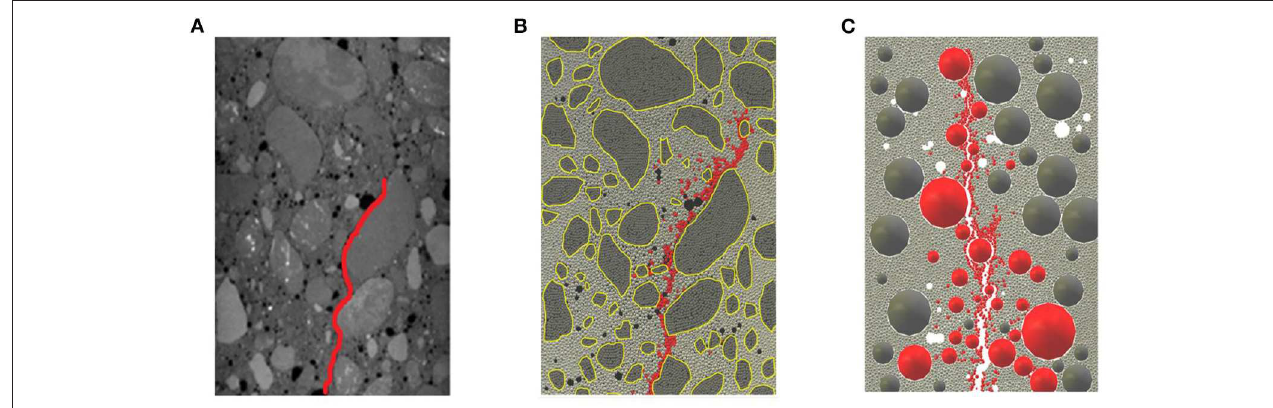
FIGURE 1 | (Color online) Mapping of the experimental sample properties to the DEM simulation (Skar˙zy´nski et al., 2015). Two-dimensional micro/meso-structure of concrete: (A) experiment (X-ray µ CT image), (B) DEM for real aggregate (clusters of spheres) and (C) DEM for real aggregate (spheres). Cracks and particles along cracks are shown in red; voids are white; aggregates are dark gray; cement matrix are light